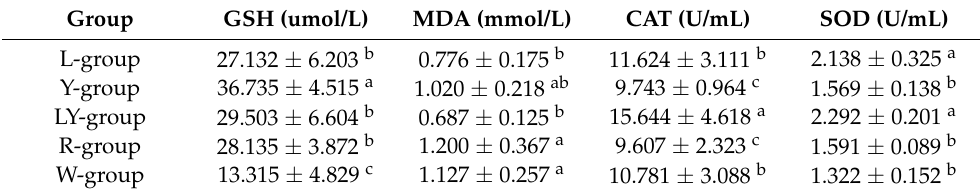
Table 3. Analysis of antioxidant ability (glutathione (GSH), malonaldehyde (MDA), catalase (CAT), and superoxide dismutase (SOD)) of mice’s serum in different experimental groups (L-group, Y- group, LY-group, R-group and